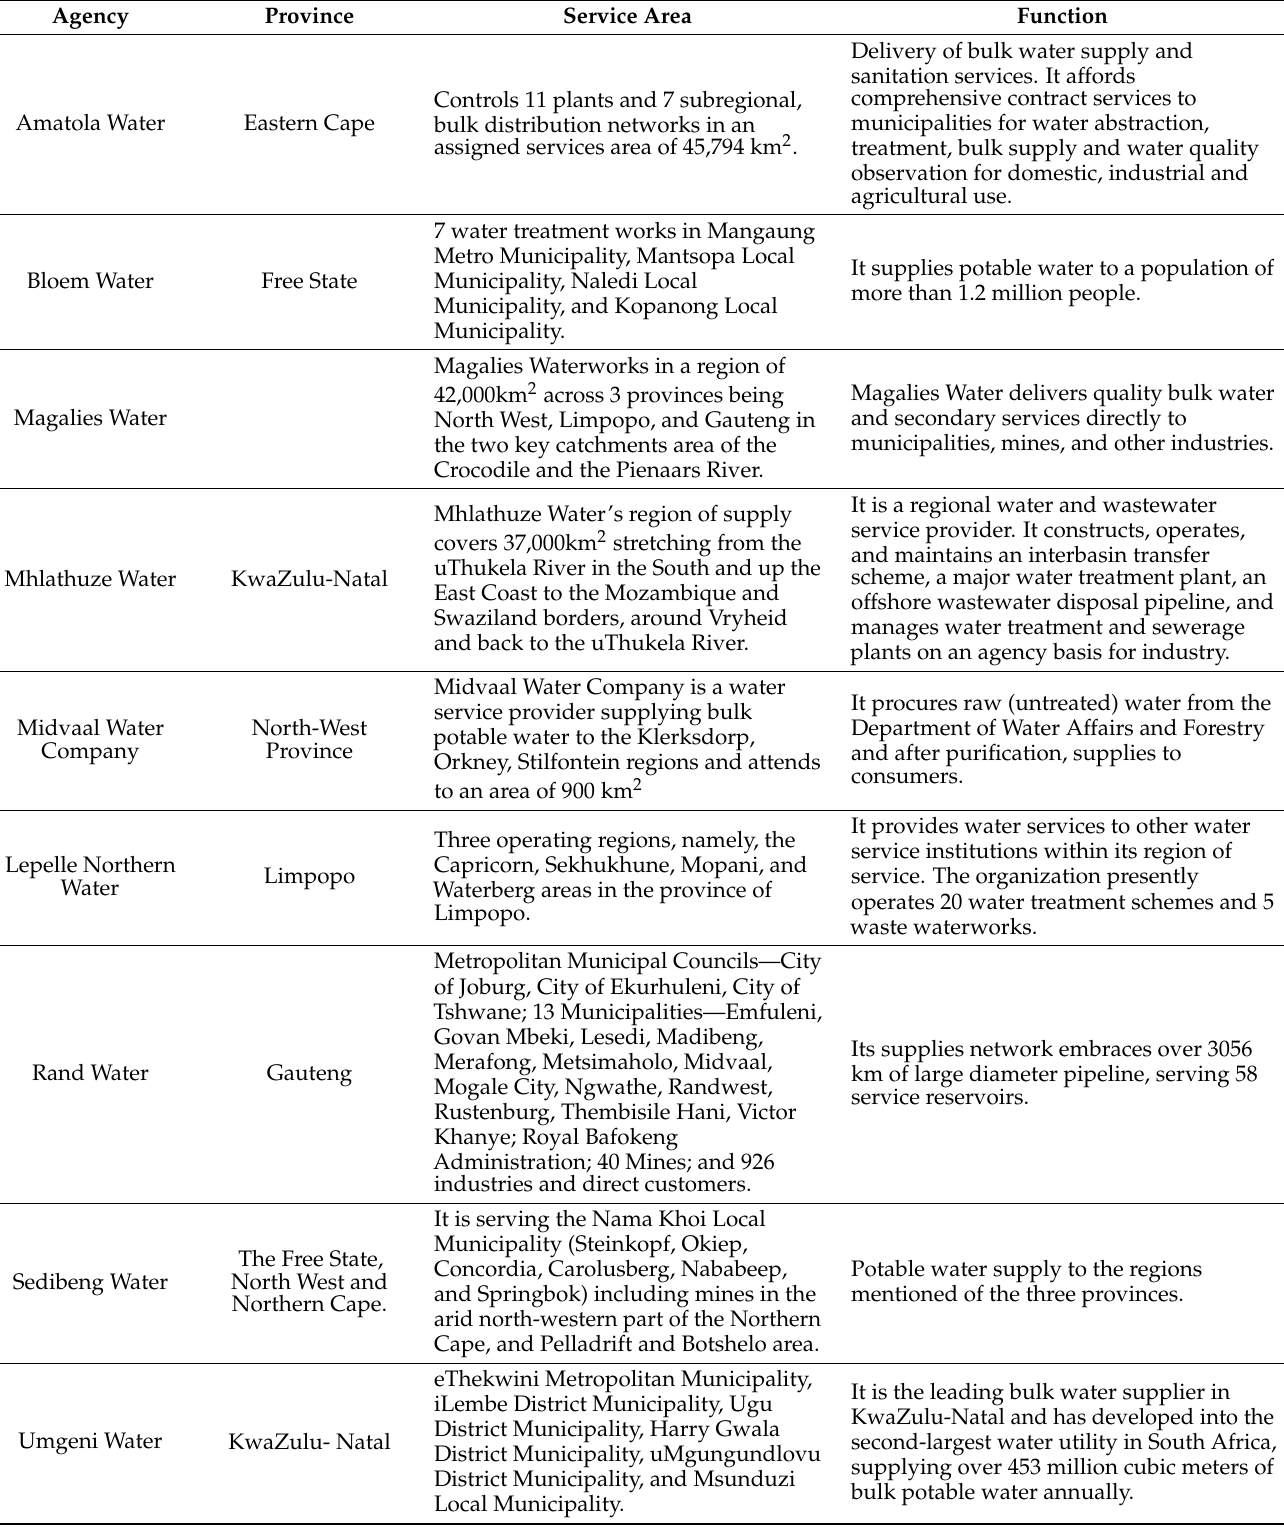
Table 1. Water utility agencies in South Africa, their service area, and